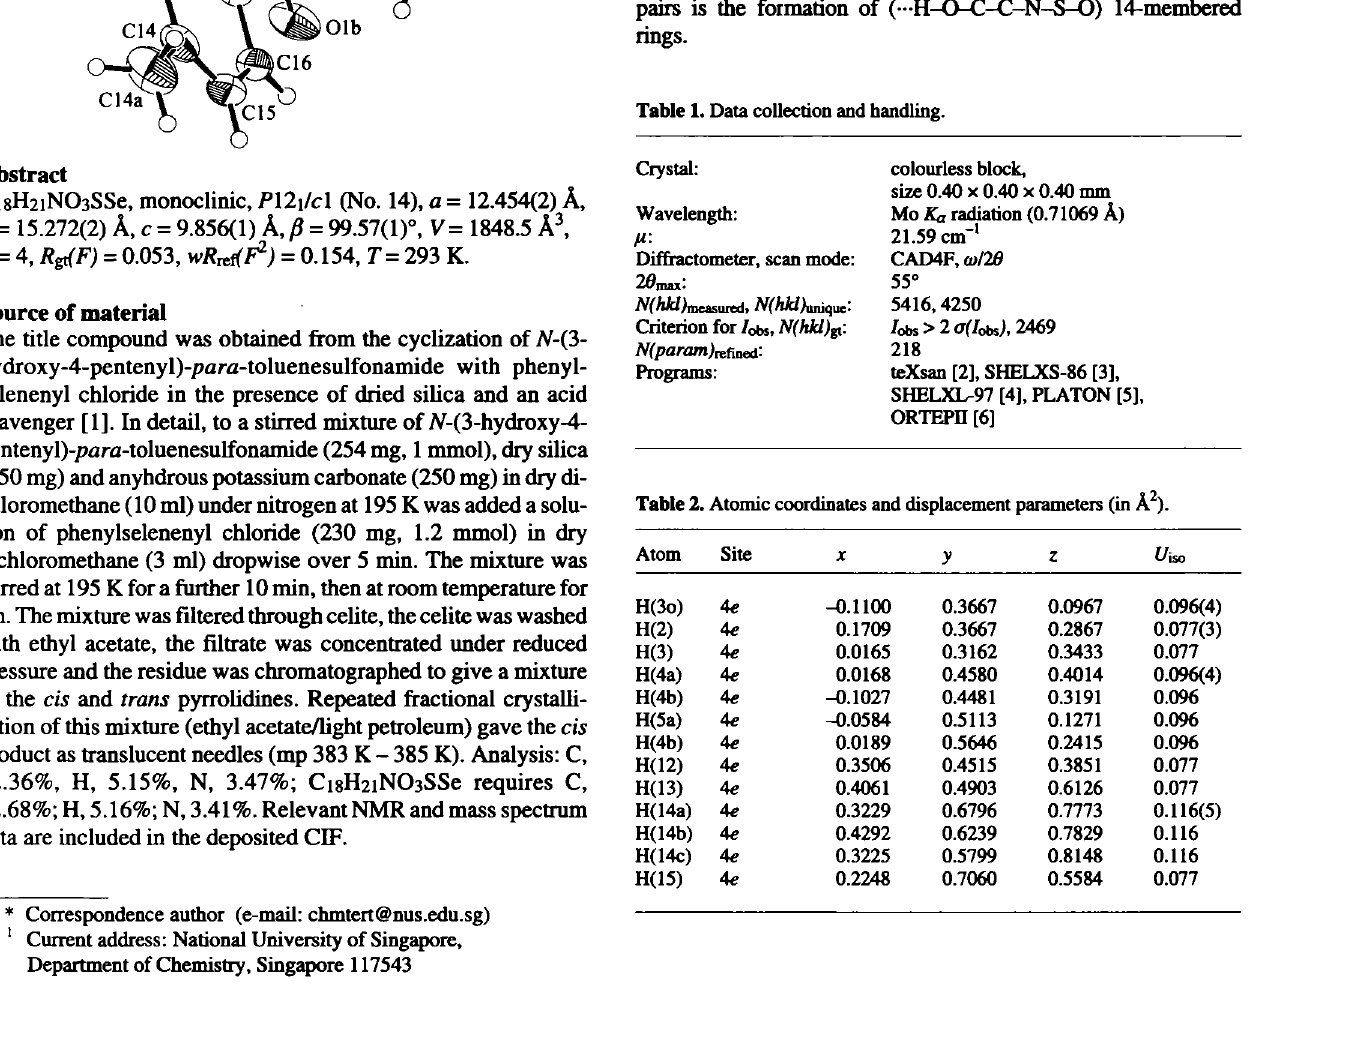
Table 1. Data collection and handling. Crystal: